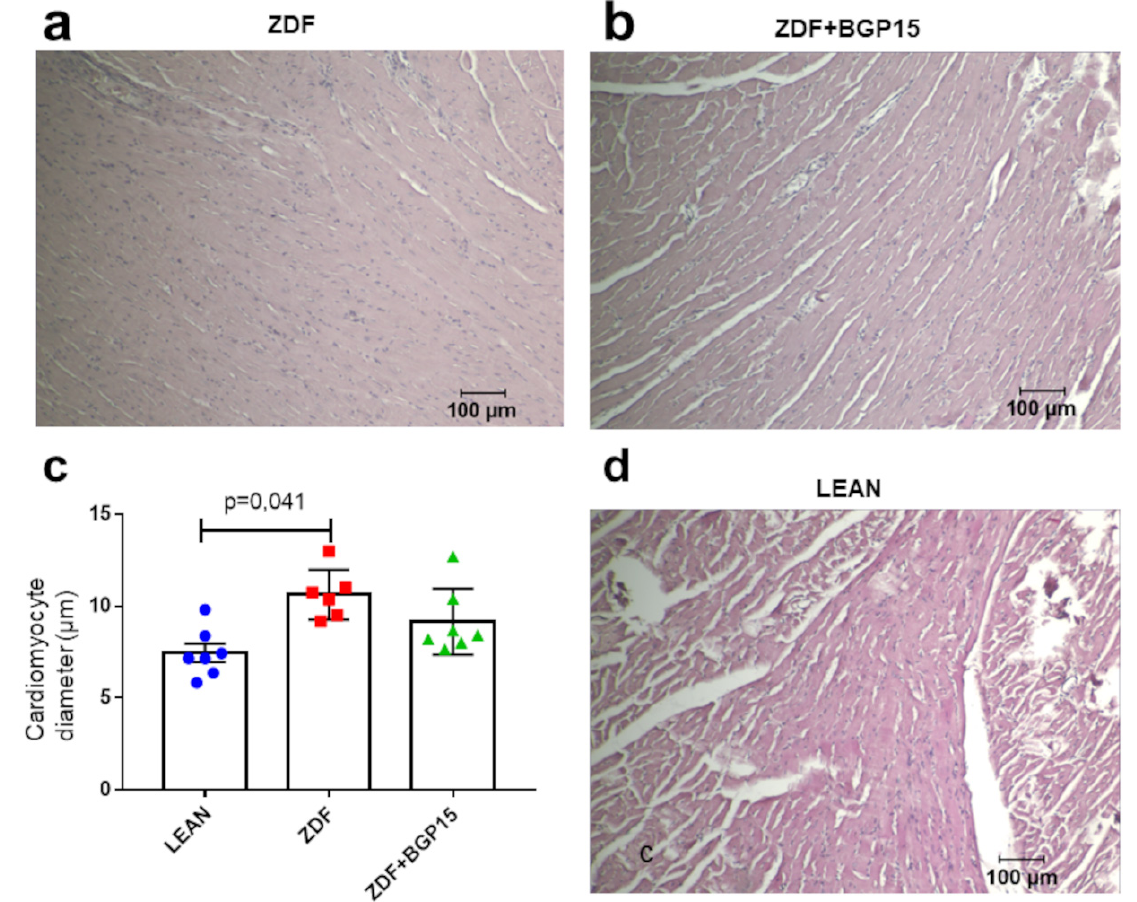
Figure 2. Histological samples stained with haematoxylin and eosin and their quantification. ( a ) Histological sample from the diseased group (ZDF), ( b ) histological sample from the BGP-15-treated ZDF group, ( c ) cardiomyocyte diameters among groups. All data are presented as mean ± standard deviation (SD, ( d ) histological sample from the control (LEAN) group, and). p < 0.05. Statistical analysis was carried out by GraphPad Prism 7.00: D’Agostino and Pearson normality test was used to estimate Gaussian distribution, and then data were analysed with ordinary one-way ANOVA or Kruskal–Wallis test. The groups were matched by Tukey’s multiple comparisons test.